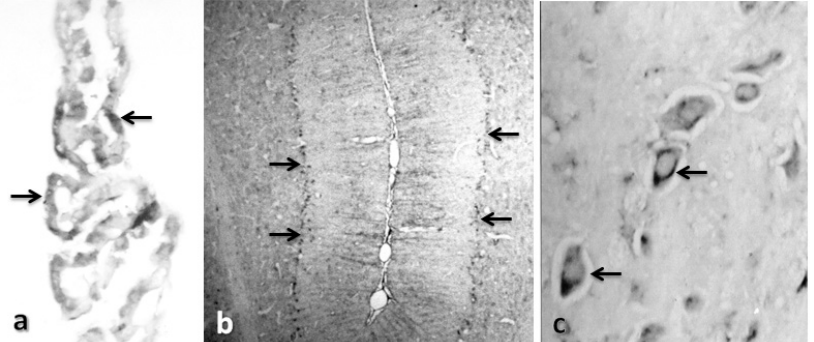
Figure 4. Immunolocalization of cystatin C in control rats. Representative micrographs of ( a ) the choroid plexus, 40×; ( b ) the cerebellum, 10×; and ( c ) the trapezoid body 40×, in a control rat. Arrows indicate cystatin C staining.